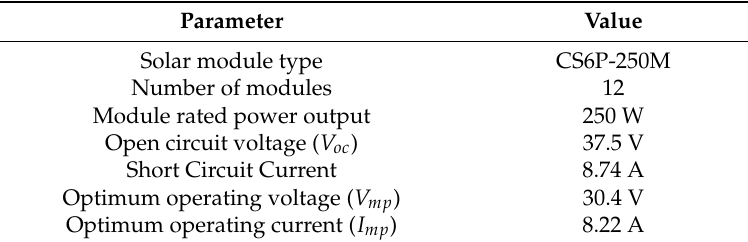
Table 3. PV array—Technical Specifications.